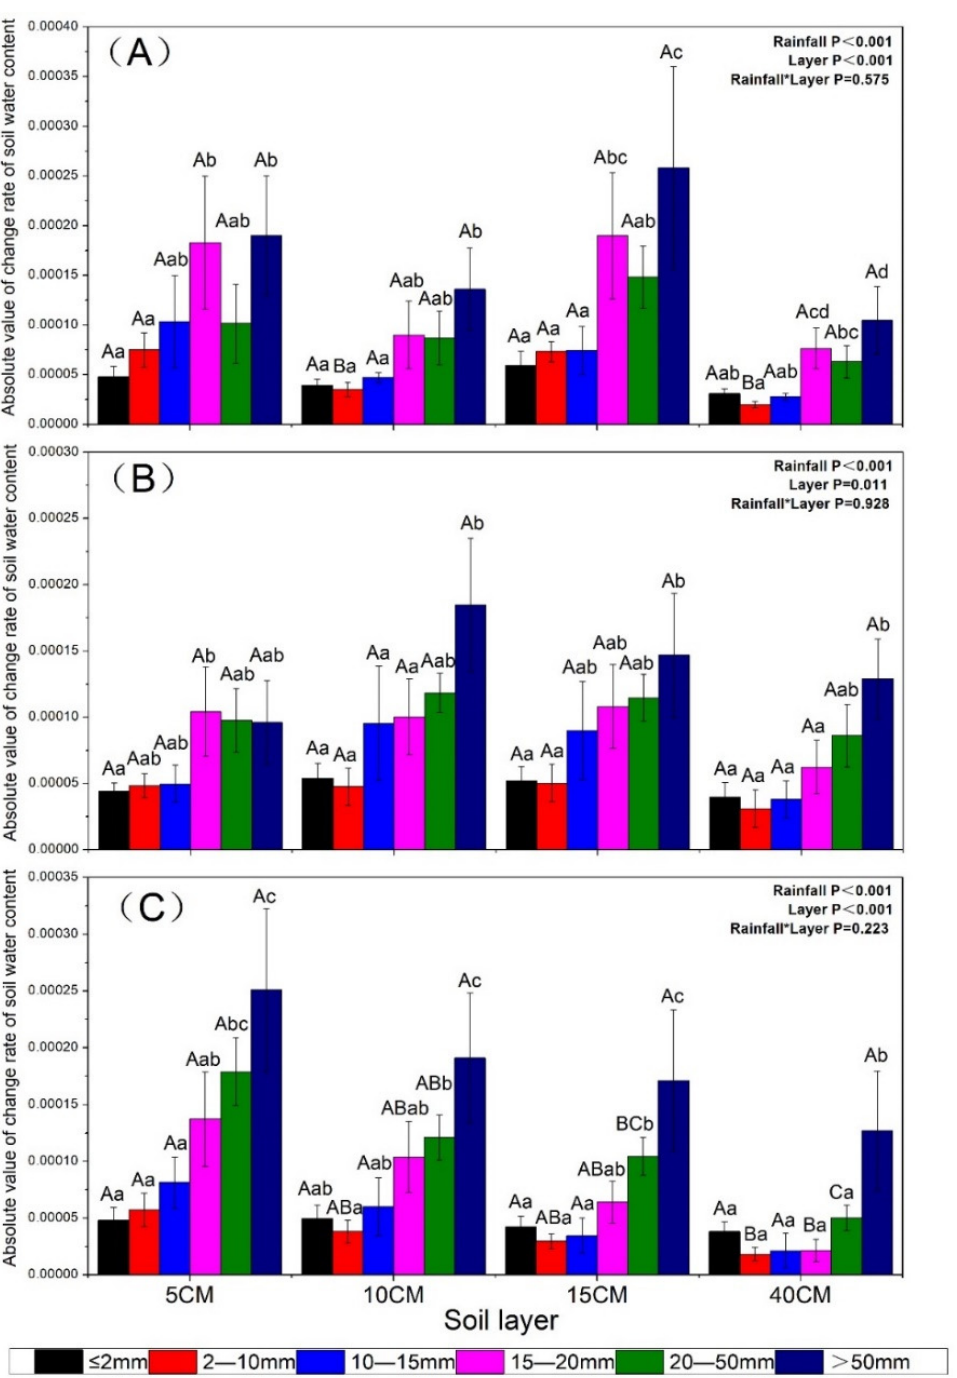
found at the right-hand end of the ordination plots, and were associated with the P ar , V pd , and wind speed. The soil temperature, T a , I 5 , A 5 , and rainfall increased along the y-axis, whereas the I 10 , I 15 , I 40 , A 10 , A 15 , A 40 , and RH decreased.